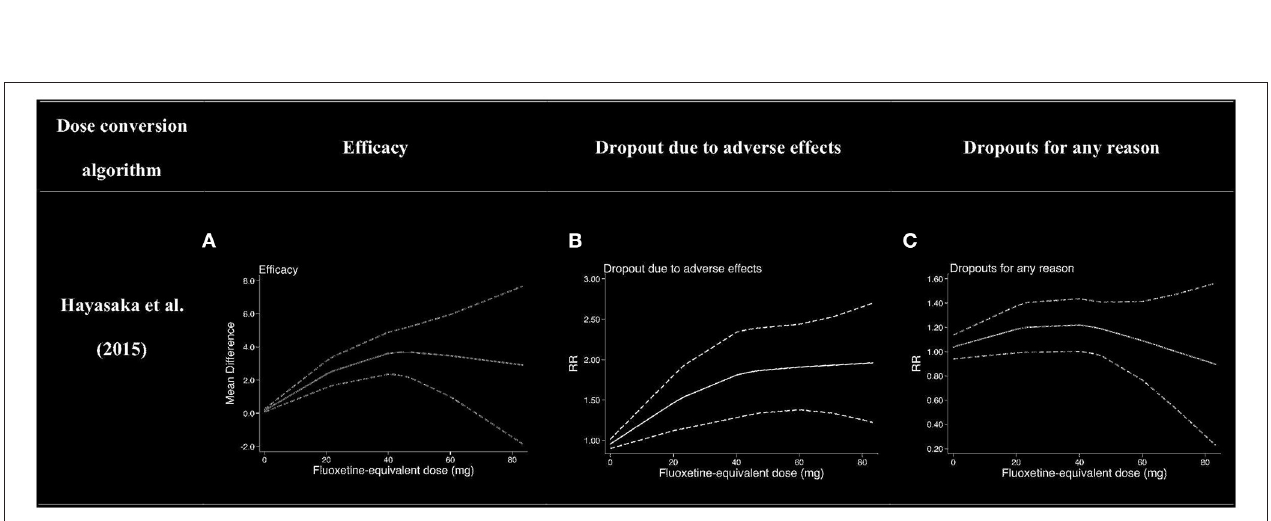
FIGURE 5 | Dose–outcome relationships for selective serotonin reuptake inhibitors (SSRIs). The studies for clomipramine were removed, and the rest were all for SSRIs. The dotted lines represent 95% confidence intervals. (A) Dose–efficacy relationship for SRIs. (B) Dose dropout due to adverse effects relationships for SRIs. (C) Dose dropout from all causes relationships for